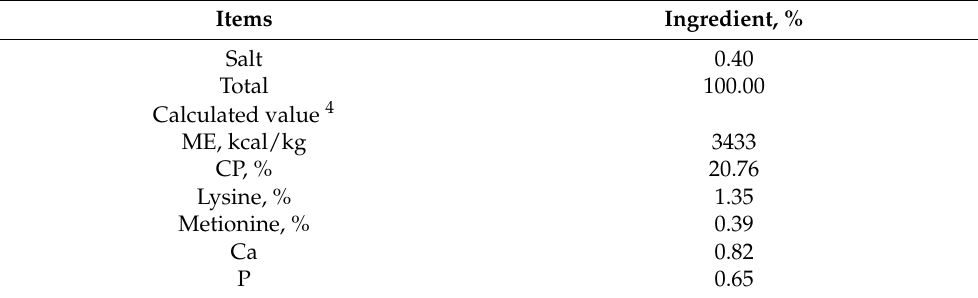
Table 1. Cont. Items Ingredient, % Salt 0.40 Total 100.00 Calculated value